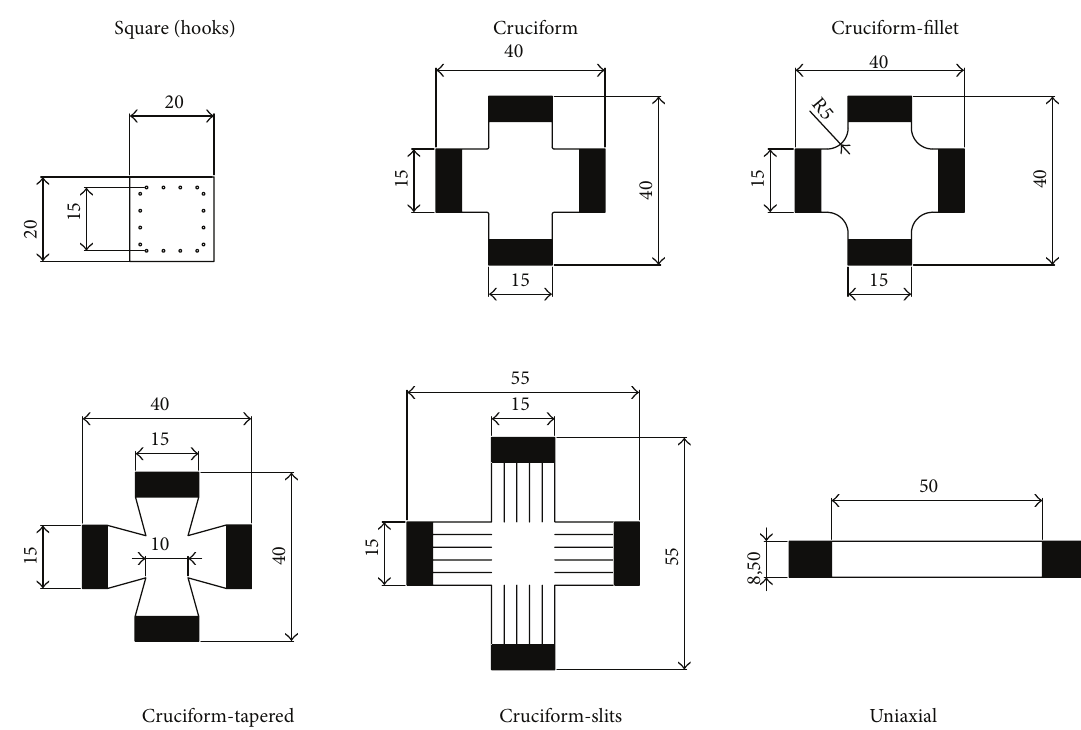
Figure 3: Specimens (dimensions in